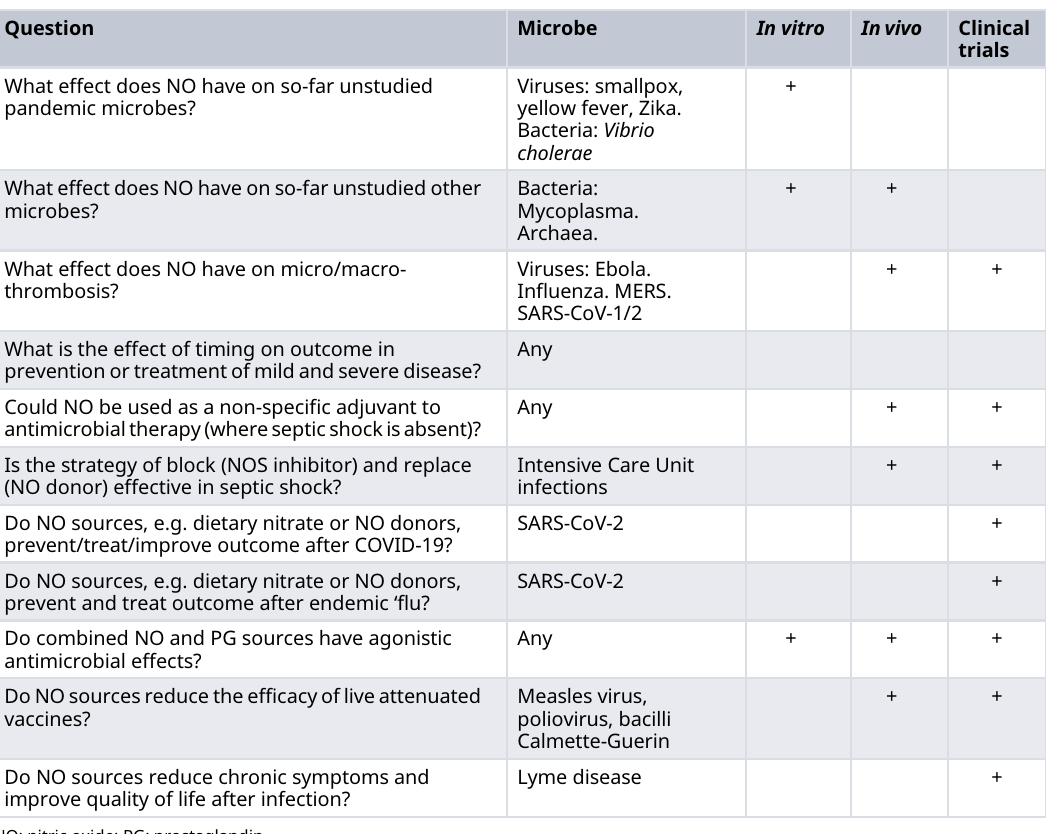
Table 10. Future research questions relating to nitric oxide therapy for microbes.